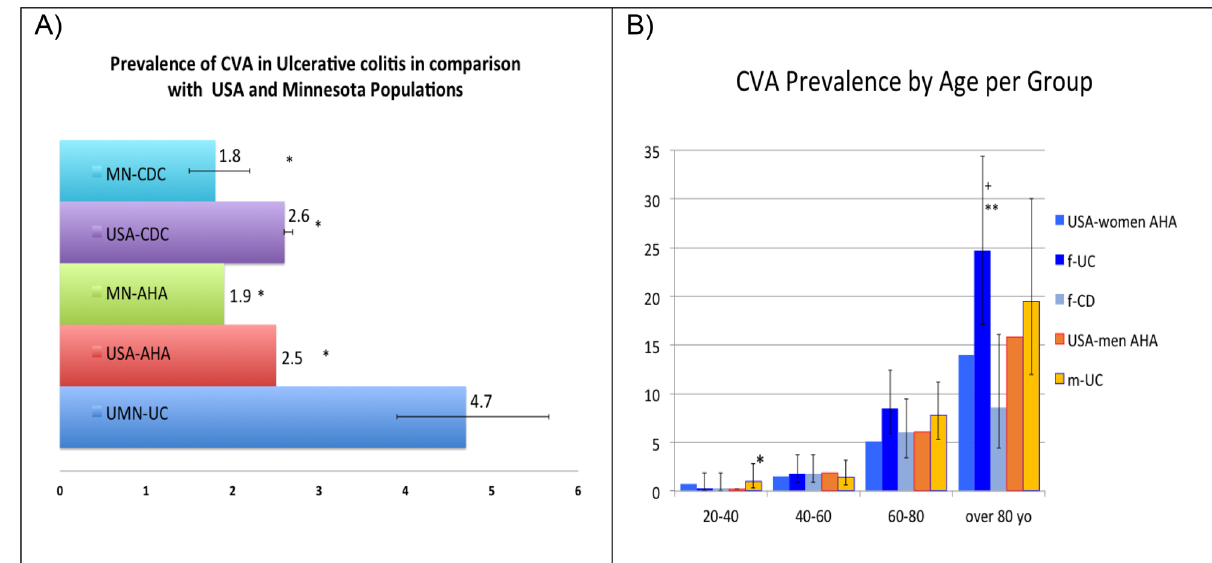
Figure 2. ( a ) Prevalence of cerebral vascular accidents in ulcerative colitis patients in comparison with country and state data, *p < 0.0001 ( b ) CVA prevalence by age and group, *p = 0.0024 when comparing with USA-men AHA, **p = 0.0029 when comparing with USA-women AHA, + p = 0.0003 when comparing with UMN-women CD; CVA cerebrovascular accident, MN Minnesota, CDC Centers for Disease Control and Prevention, AHA American Heart Association, UC ulcerative colitis, yo years